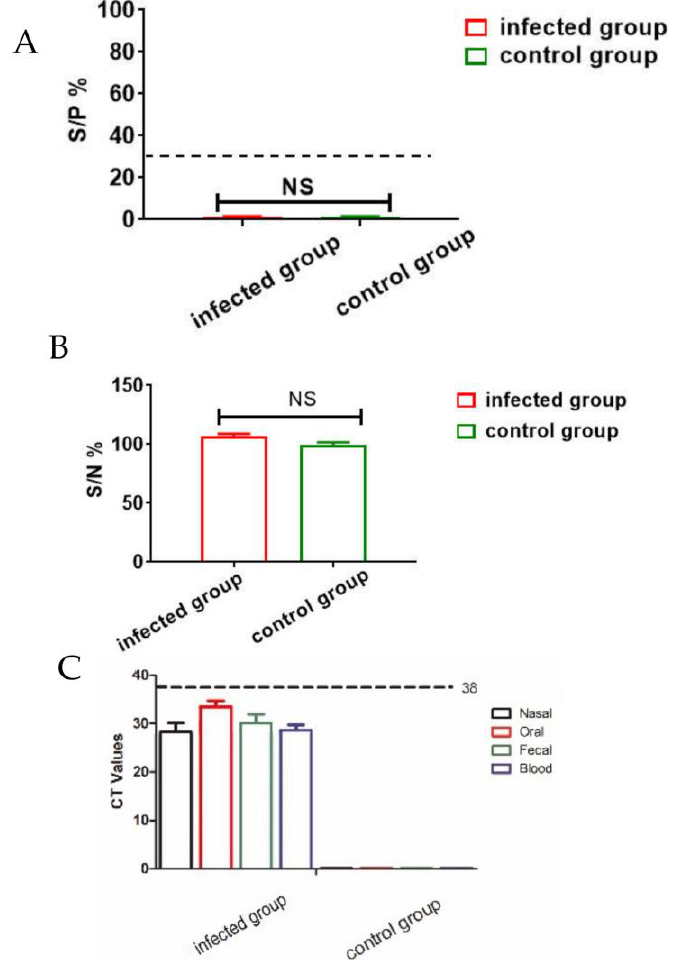
Figure 2. Clinical sample analysis by ELISA and qPCR. ( A , B ) Analysis of ASFV antibody levels in serum samples from infected group and control group were detected by using indirect ELISA (S/P% ≤ 30%) ( A ) and competition ELISA (S/N% ≥ 50%) ( B ). NS: there is no significant difference between infected group and control group. ( C ) ASFV B646L (p72) gene detection in different samples by qPCR. DNA was extracted from nasal, oral, fecal and blood samples from infected group and control group. The error bars represent the standard deviation among replicates. Data are shown as the mean ± SD based on three independent